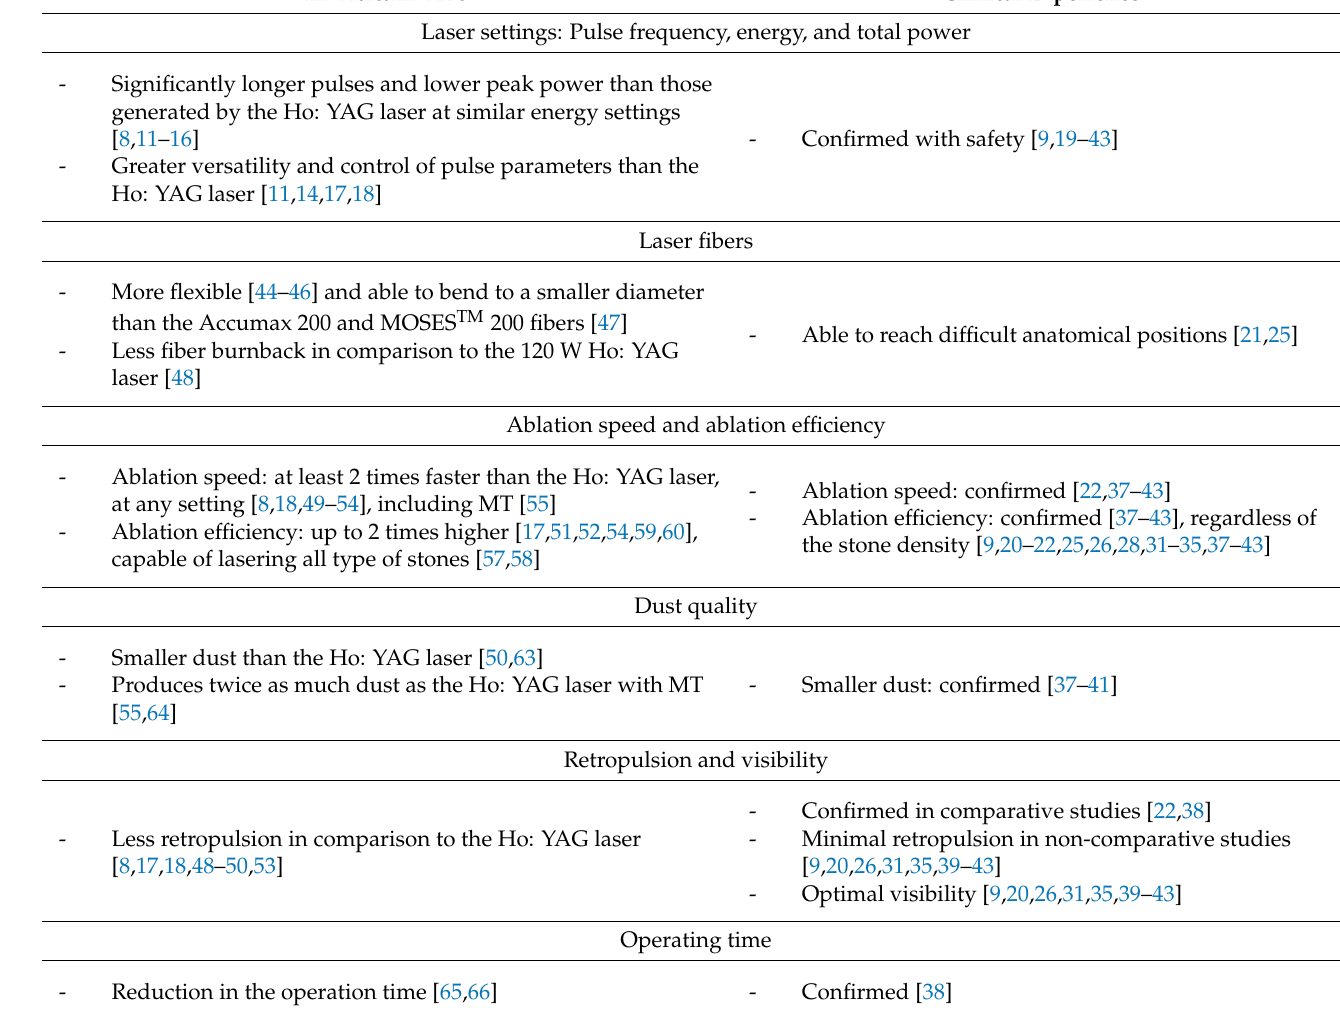
Table 1. Comparison between TFL preclinical and clinical studies. In Vitro/In Vivo Clinical